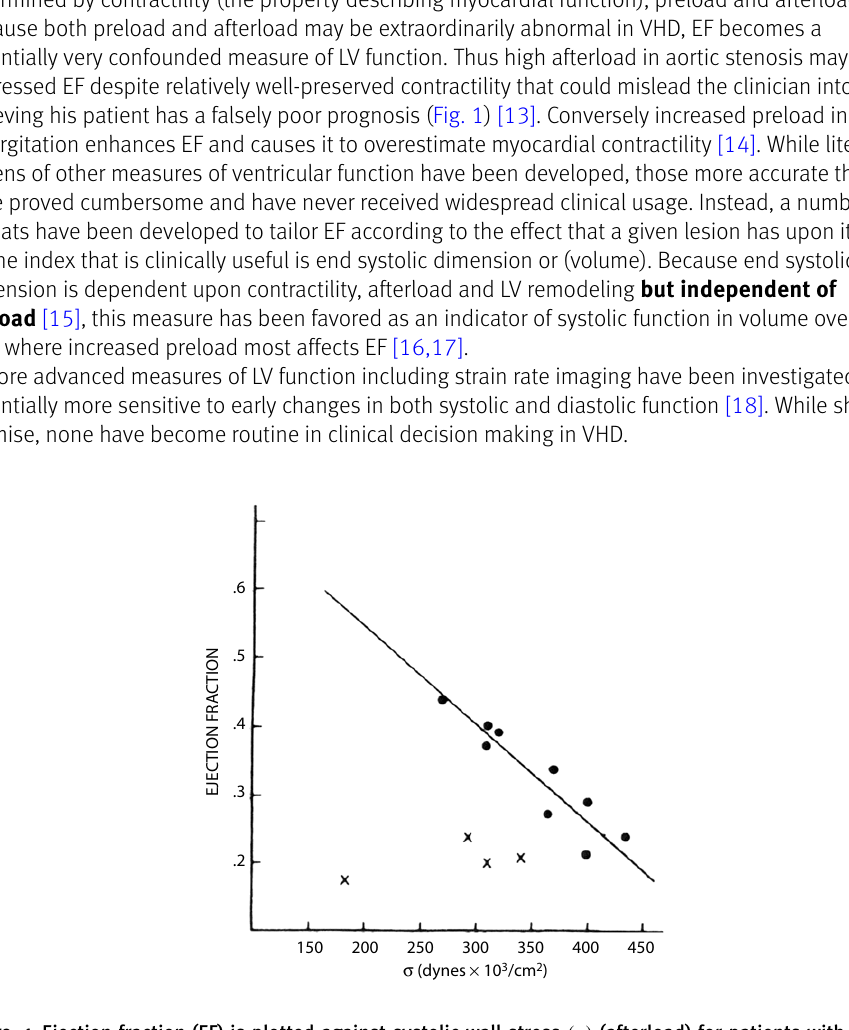
Figure. 1 Ejection fraction (EF) is plotted against systolic wall stress (σ) (afterload) for patients with AS and heart failure. For some patients (circles) EF is reduced almost entirely due to excess afterload. In others, (x) EF is reduced primarily due to myocardial damage and contractile dysfunction. Taken with permission from Ref.